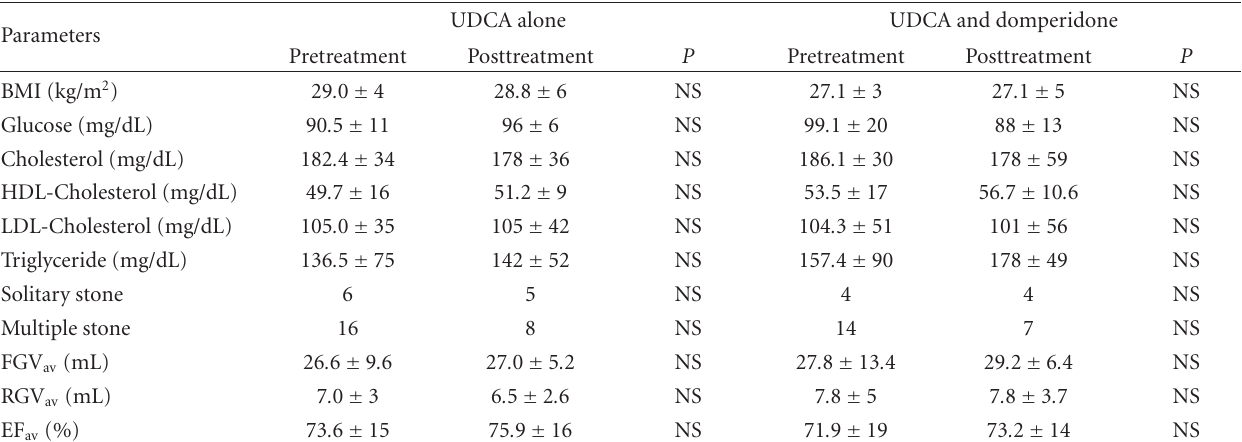
Table 3: Characterisitcs of patients in treatment groups in pre- and posttreatment ∗ . UDCA alone UDCA and domperidone Parameters Pretreatment Posttreatment Glucose (mg/dL) Cholesterol (mg/dL) HDL-Cholesterol